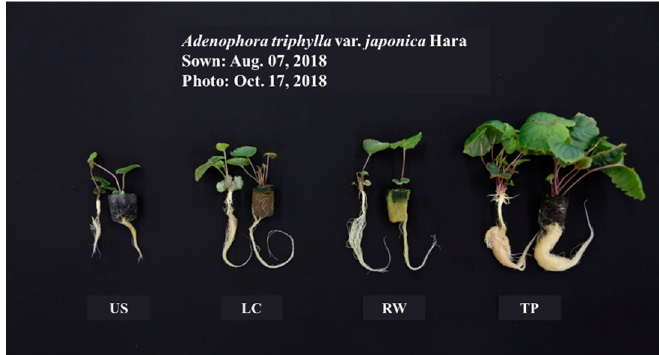
Figure 2. Growth of Adenophora triphylla var. japonica Hara seedlings as affected by different media at